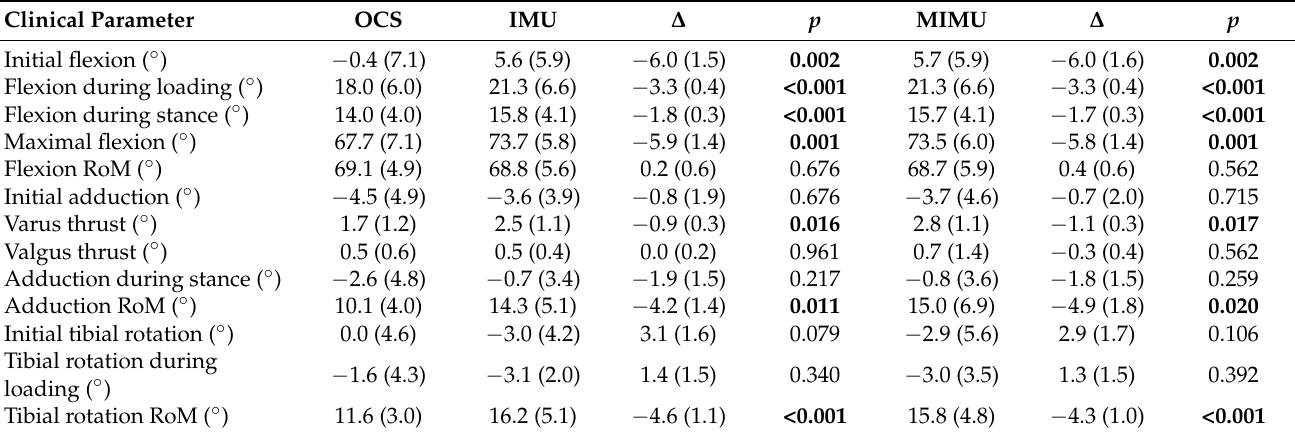
Table 3. Comparison of the clinical parameters. Paired t -tests were used and significant p -values are identified in bold ( p -value < 0.05).